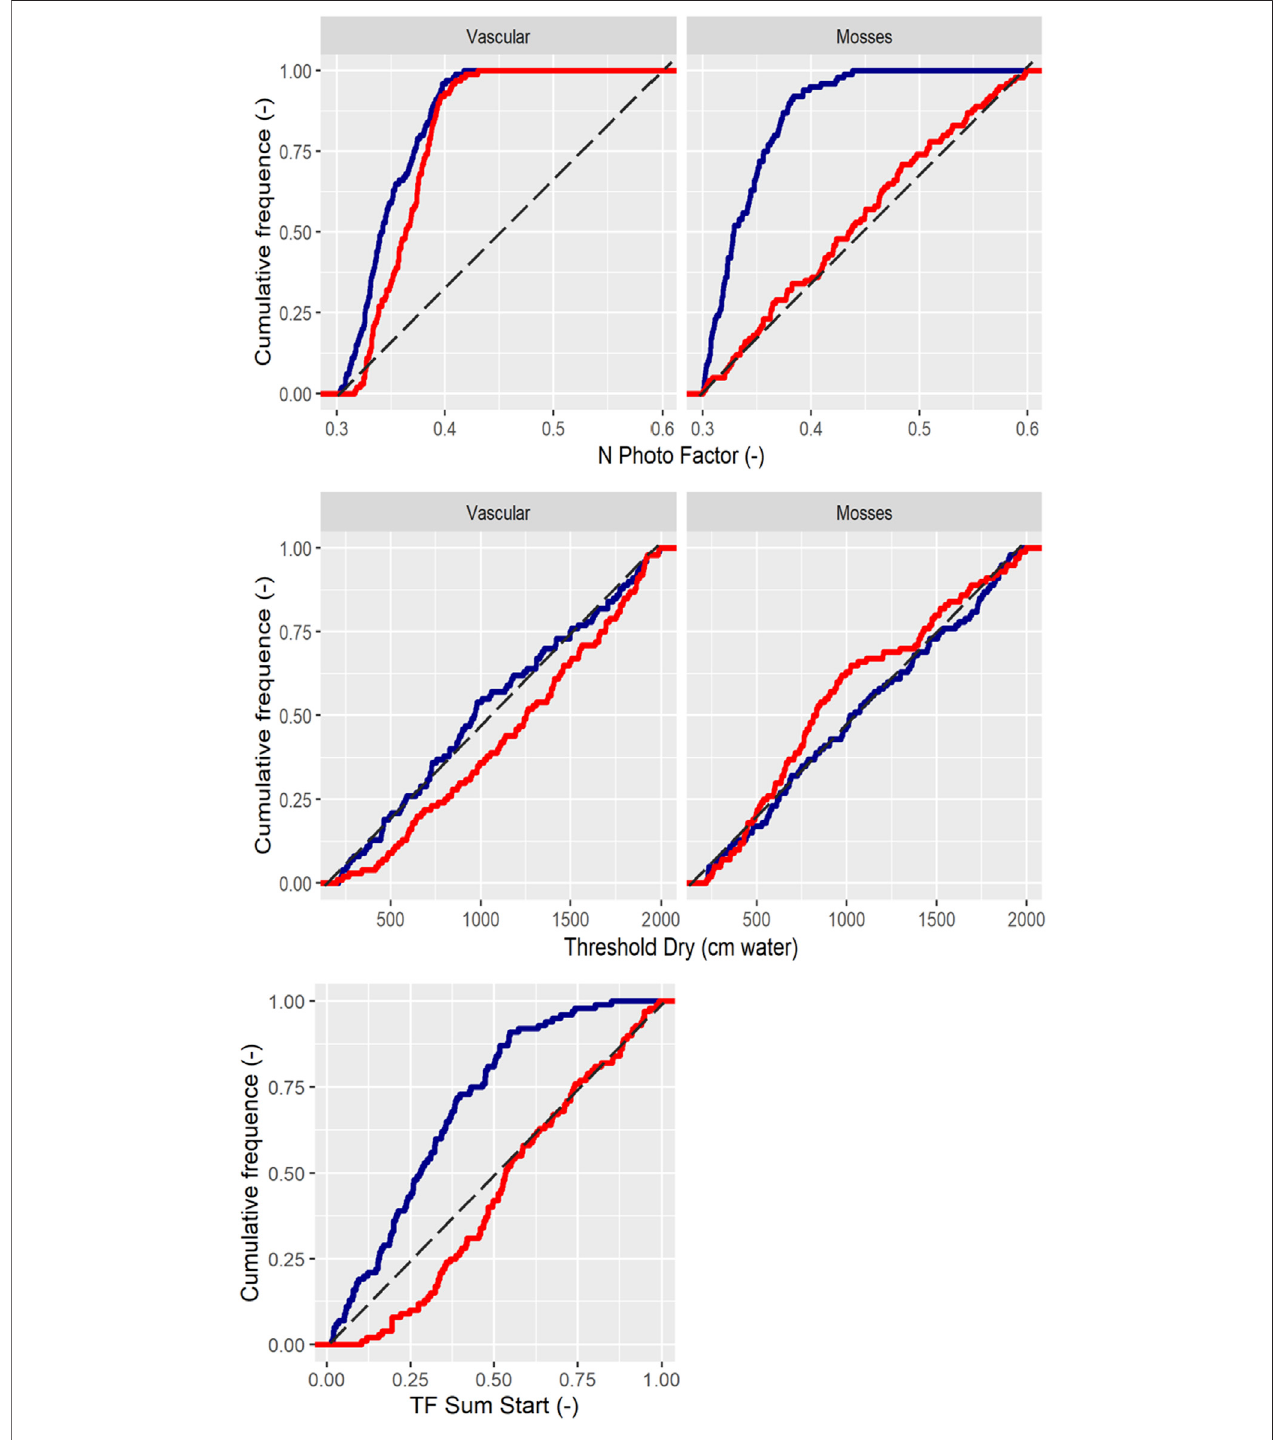
FIGURE 2 | The cumulative frequency distribution of accepted parameter values associated with plant growth. K (cid:1) blue and L (cid:1) red.